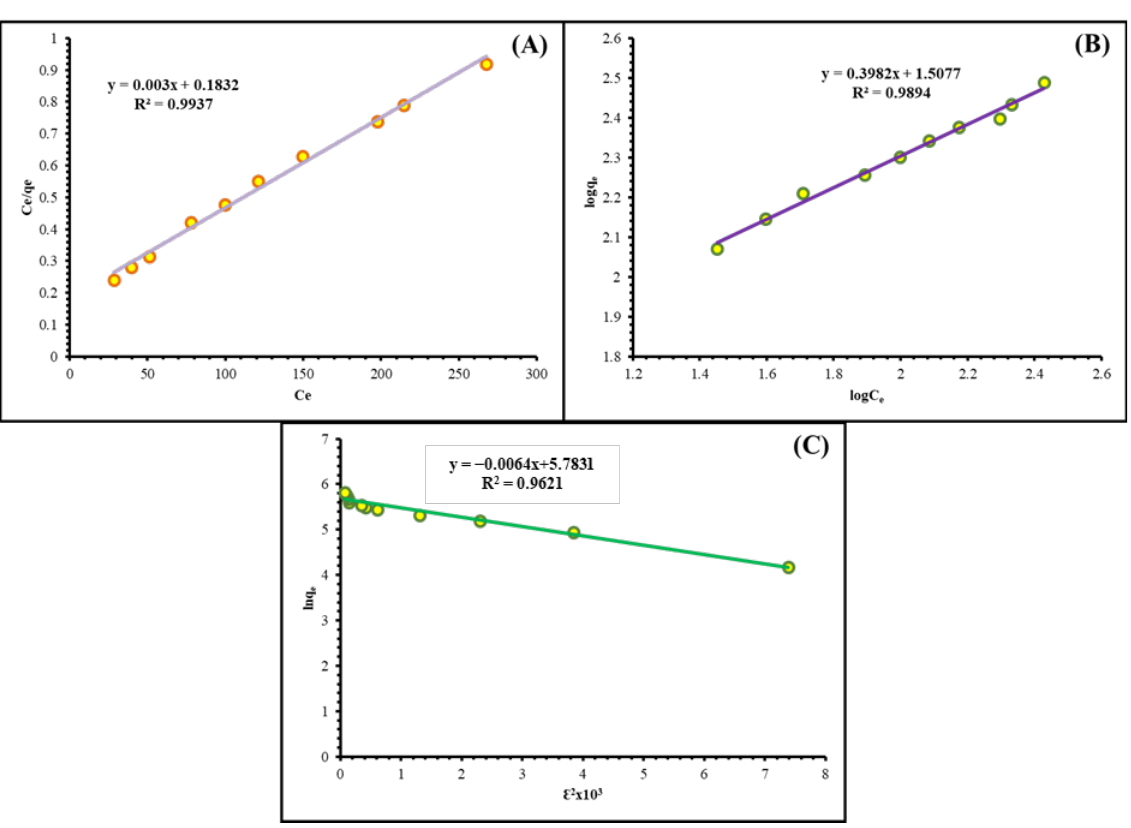
Figure 12. ( A ) Freundlich, ( B ) Freundlich, and ( C ) Dubinin–Radushkevich isotherm models of W(VI) ions adsorbed on HNAP/QA. Table 3. Isotherms parameters of W(VI) ions adsorbed on